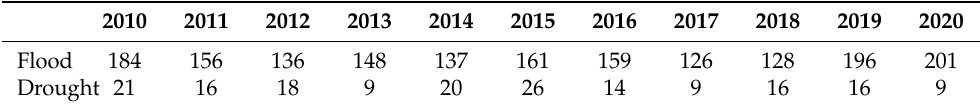
Table 1. Number of flood and drought events